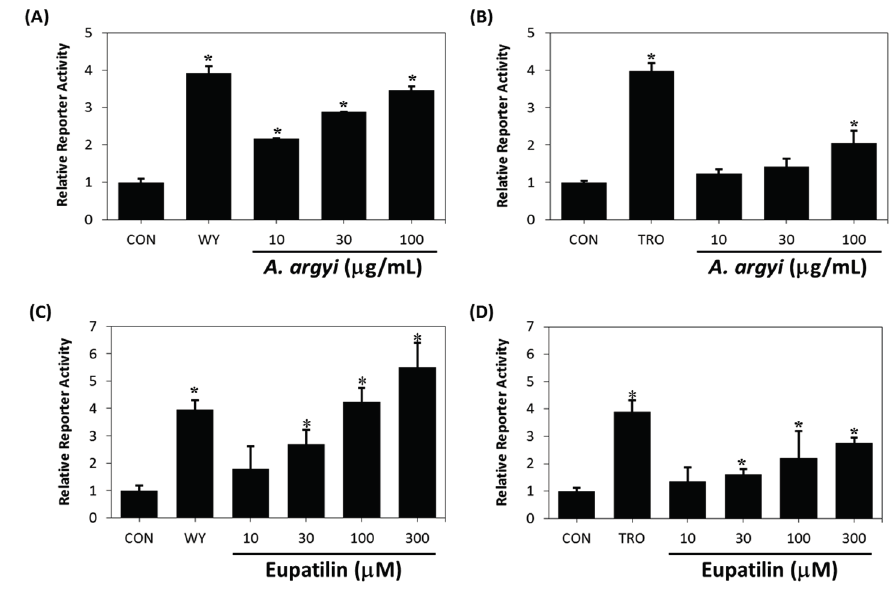
Figure 4. The A. argyi extract and eupatilin activate PPAR α ( A , C ) and PPAR γ ( B , D ) in vitro . Human PPAR α and PPAR γ expression vector, PPRE-luciferase reporter construct, and pRL-SV40 vector were transiently cotransfected in CV-1 cells. The cells were then treated with 10 μ M WY14643 (WY), 10 μ M troglitazone (TRO) or various concentrations of A. argyi extract (10, 30, 100 μ g·mL − 1 ) for 24 h. A reporter assay was performed as described in the Experimental Section. Each bar represent the mean ± SD of triplicate experiments. * p < 0.05 vs.